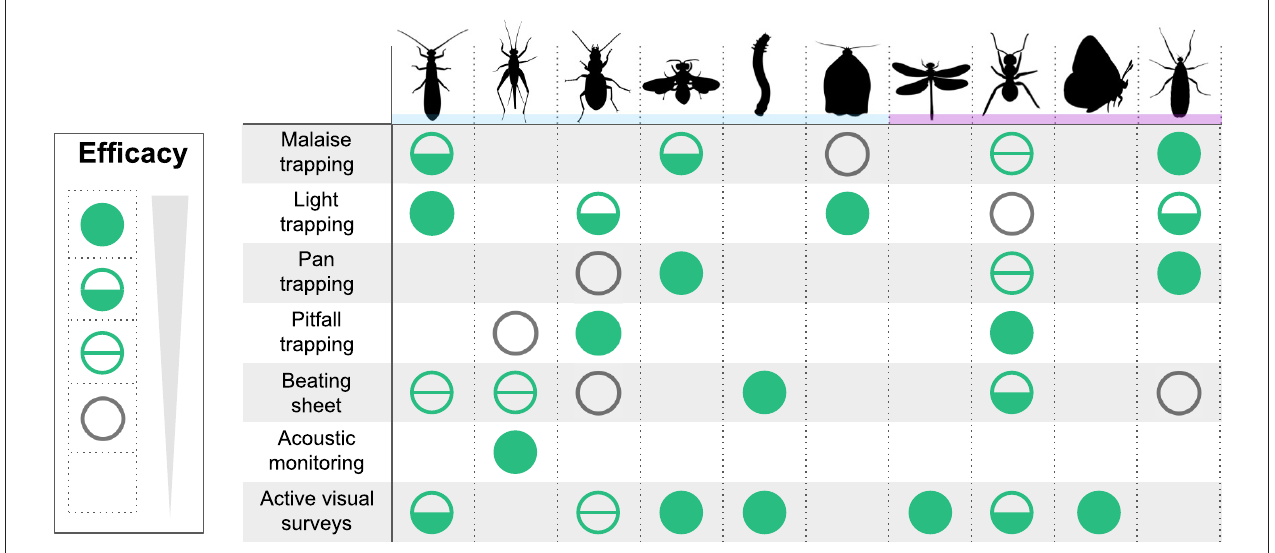
FIGURE 1 | Commonly-monitored insect guilds and taxa and the efficacy for each of seven benchmarking methods. Efficacy of each method for a given insect group is scored as follows: filled green circles indicate optimal suitability; half-filled circles indicate possible suitability; divided, unfilled circles indicate marginal suitability; unfilled gray circles indicate bycatch only; and no circle indicates general unsuitability. Insect groupings are defined by ecological traits (blue bar) or taxonomic clades (purple bar). In order by column, insect groupings are: adult semi-aquatic insects (Plecoptera, Ephemeroptera, and Trichoptera); singing insects (Orthoptera & Hemiptera: Cicadoidea); ground-dwelling beetles (Coleoptera: Carabidae and Staphylinidae); non-lepidopteran pollinators (Hymenoptera, Diptera, Coleoptera); leaf-chewing larvae (Lepidoptera and Hymenoptera: Symphyta); night-active moths (Lepidoptera); dragonflies and damselflies (Odonata); ants (Hymenoptera: Formicidae); butterflies (Lepidoptera: Papilionoidea); and flies (Diptera).